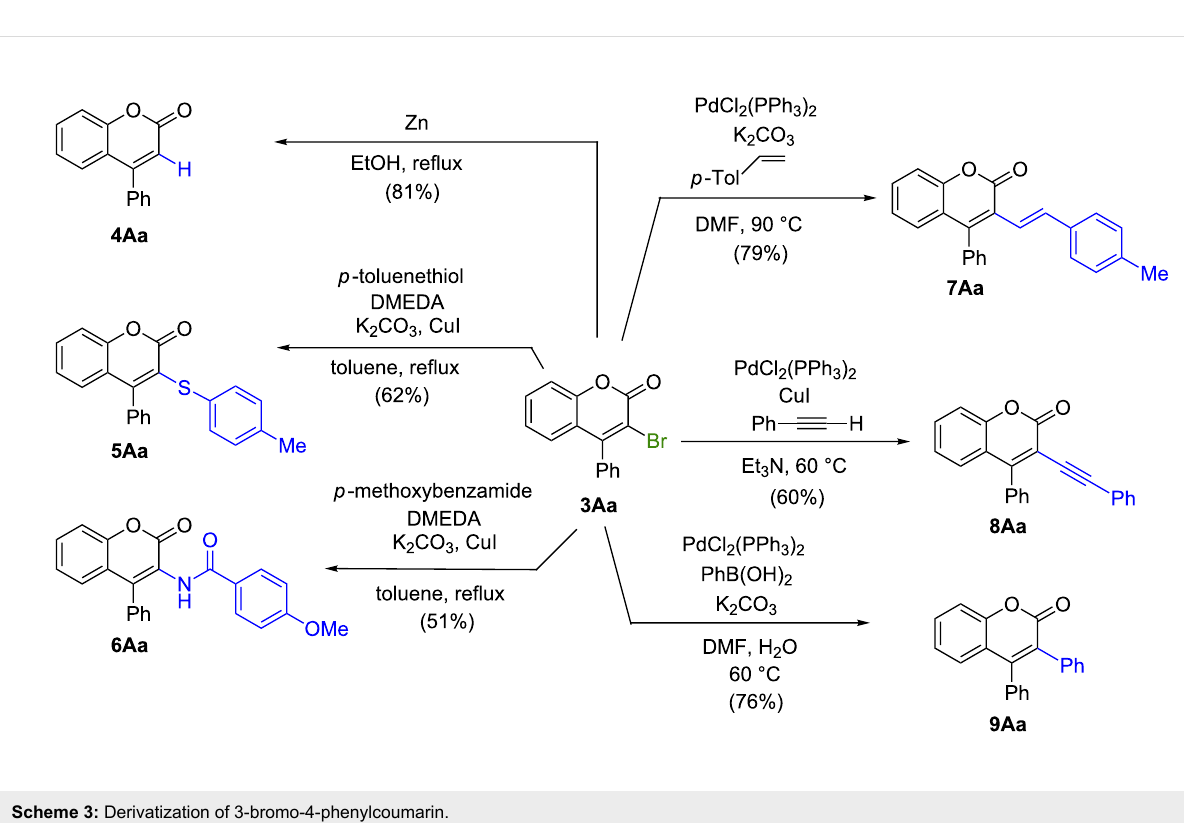
Scheme 3: Derivatization of 3-bromo-4-phenylcoumarin.